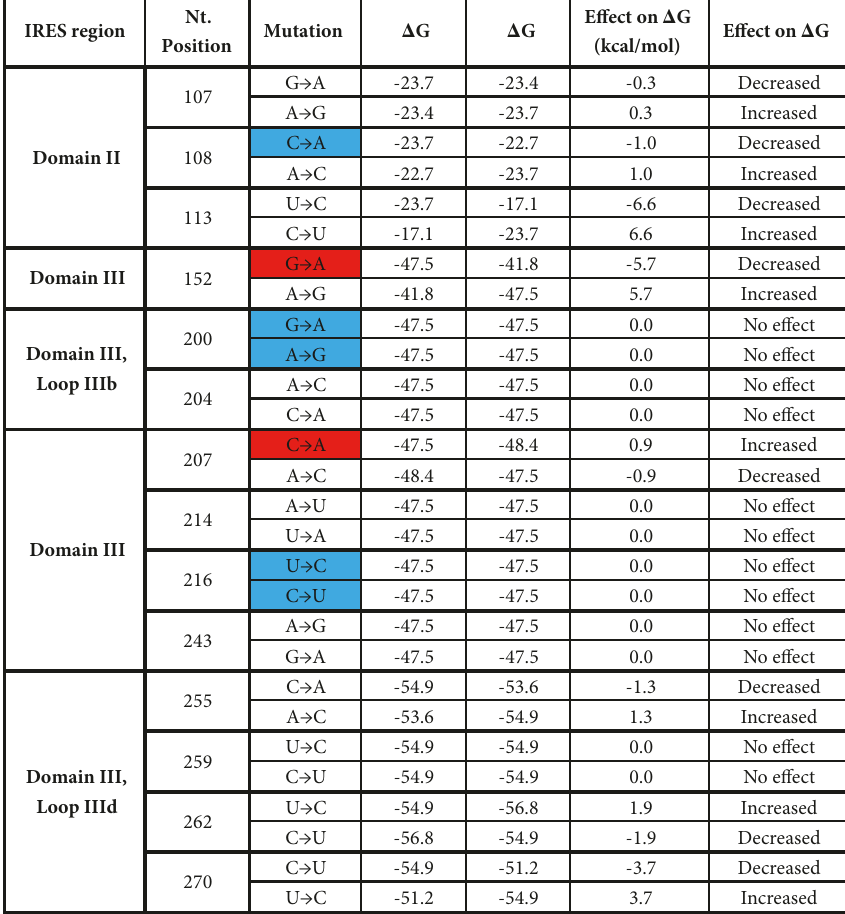
PBMC-derived IRESes, may help HCV to possibly reduce HCV translation and avoid immune